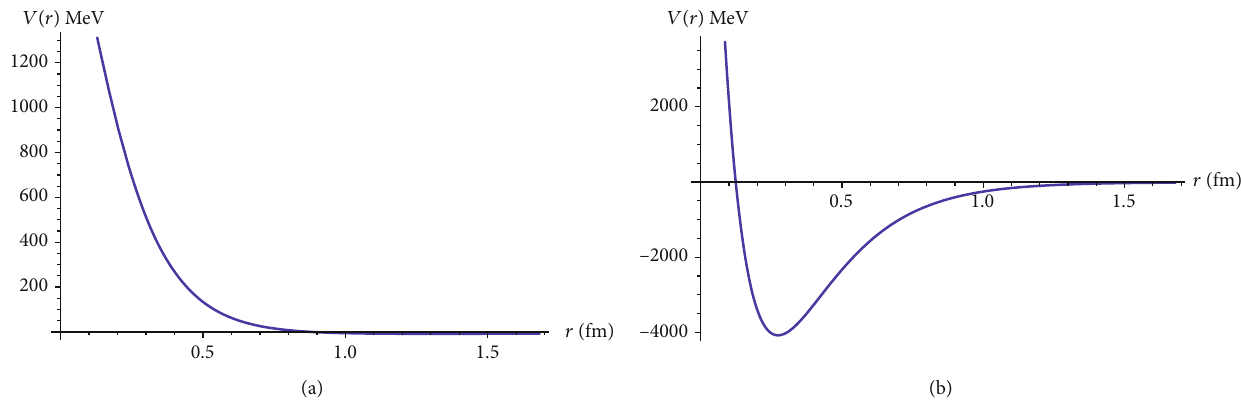
Figure 2: The potential with GY and SPED functions, respectively, of 4 He nuclei as OBEP through the exchange of σ and ω mesons, with parameter I.